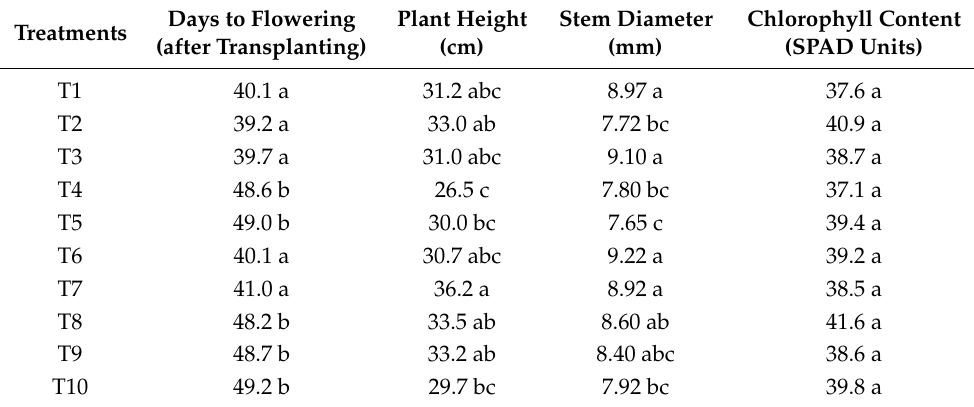
Table 3. Plant growth parameters of pepper plants grown under the different treatments. Treatments